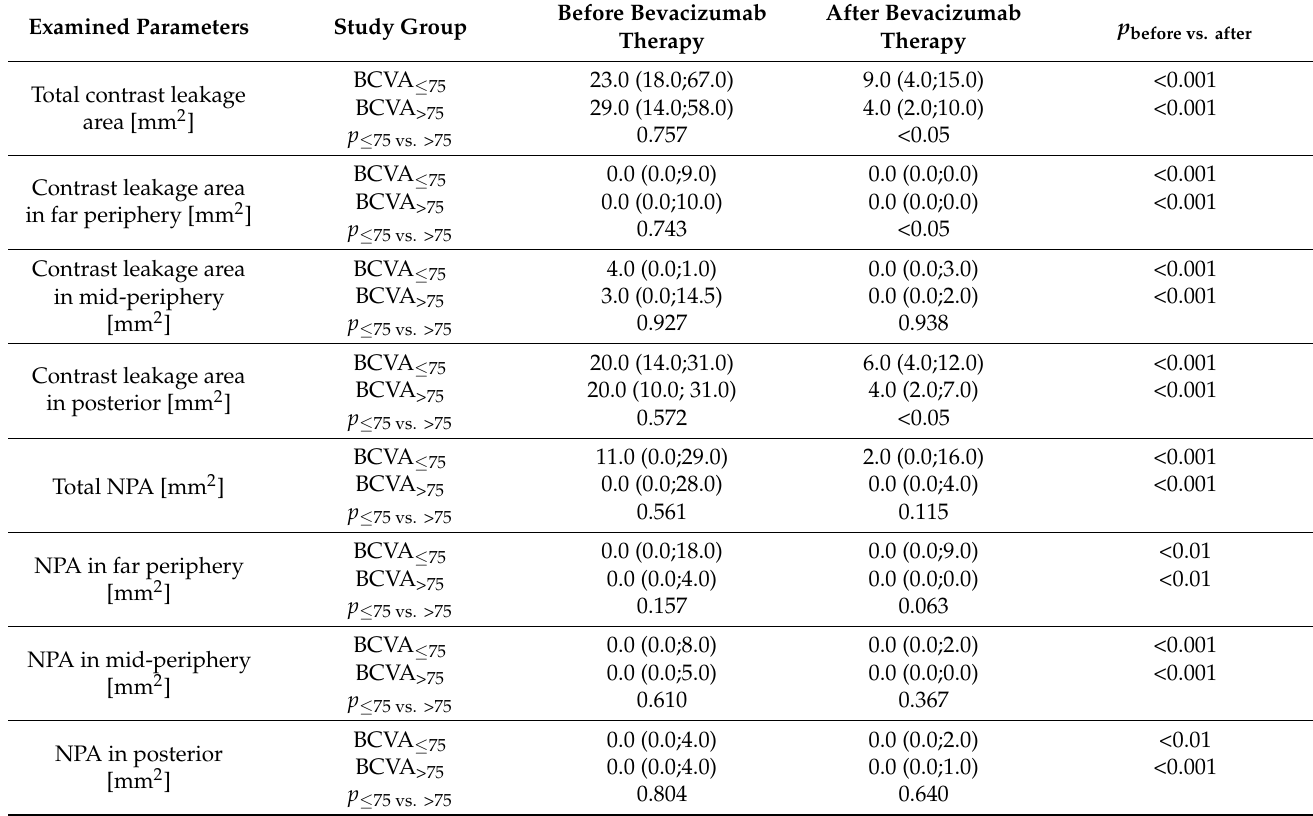
Table 6. Comparison of contrast leakage areas and non-perfusion areas before and after bevacizumab treatment in the BCVA ≤ 75 group ( n = 41) and the BCVA >75 group ( n = 57) of patients with diabetic macular edema. The results are presented as median (lower;upper quartile) Me (Q1;Q3). Statistical significance was set at p < 0.05. Examined Parameters